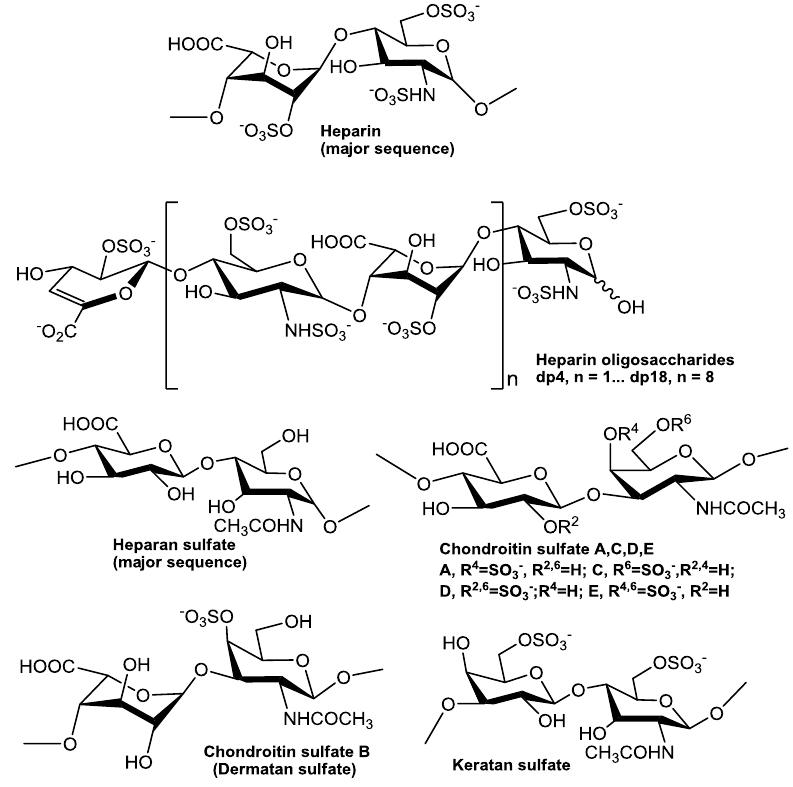
Figure 1. Chemical structures of glycosaminoglycans and heparin oligosaccharides.